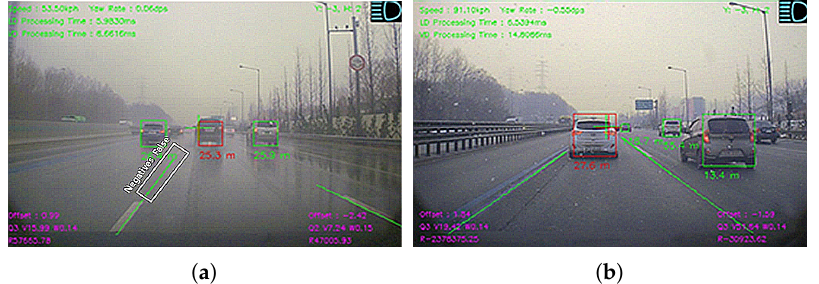
Figure 20. Real-road tests were conducted under various external situations: ( a ) heavy rain, and ( b ) snowfall.